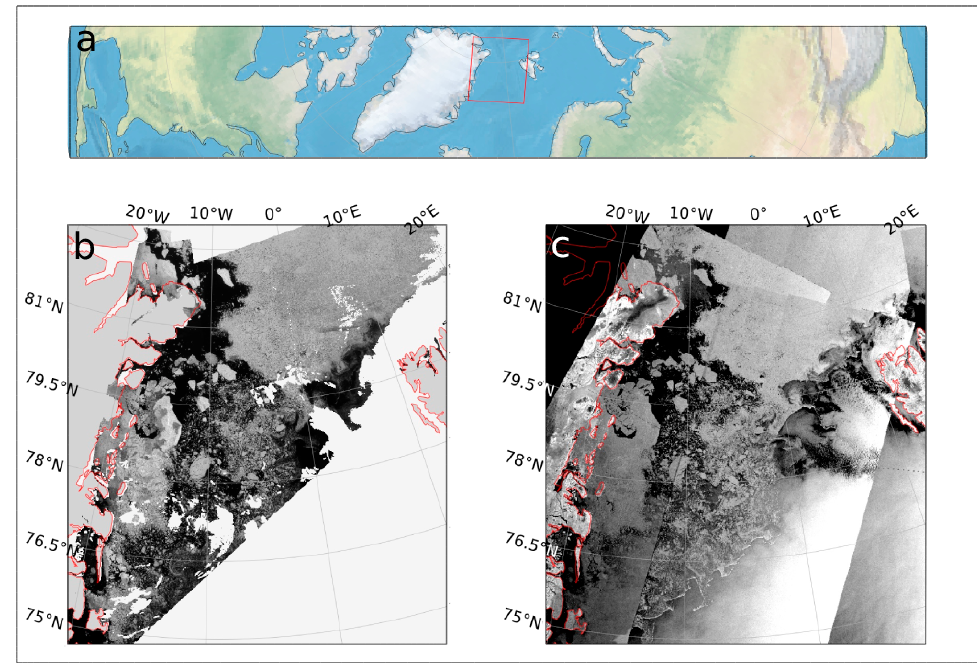
Figure 1. ( a ) Location of S-1 and S-2 images; ( b ) S-2 band-3 mosaic image from 30 July 2019; ( c ) S-1 HH polarization mosaic image from 30 July